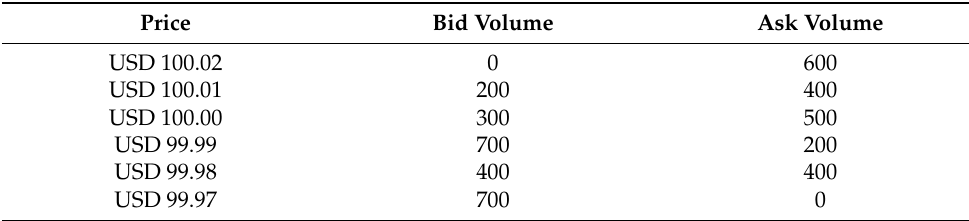
Table 1. Example of a call auction at the end of its order submission